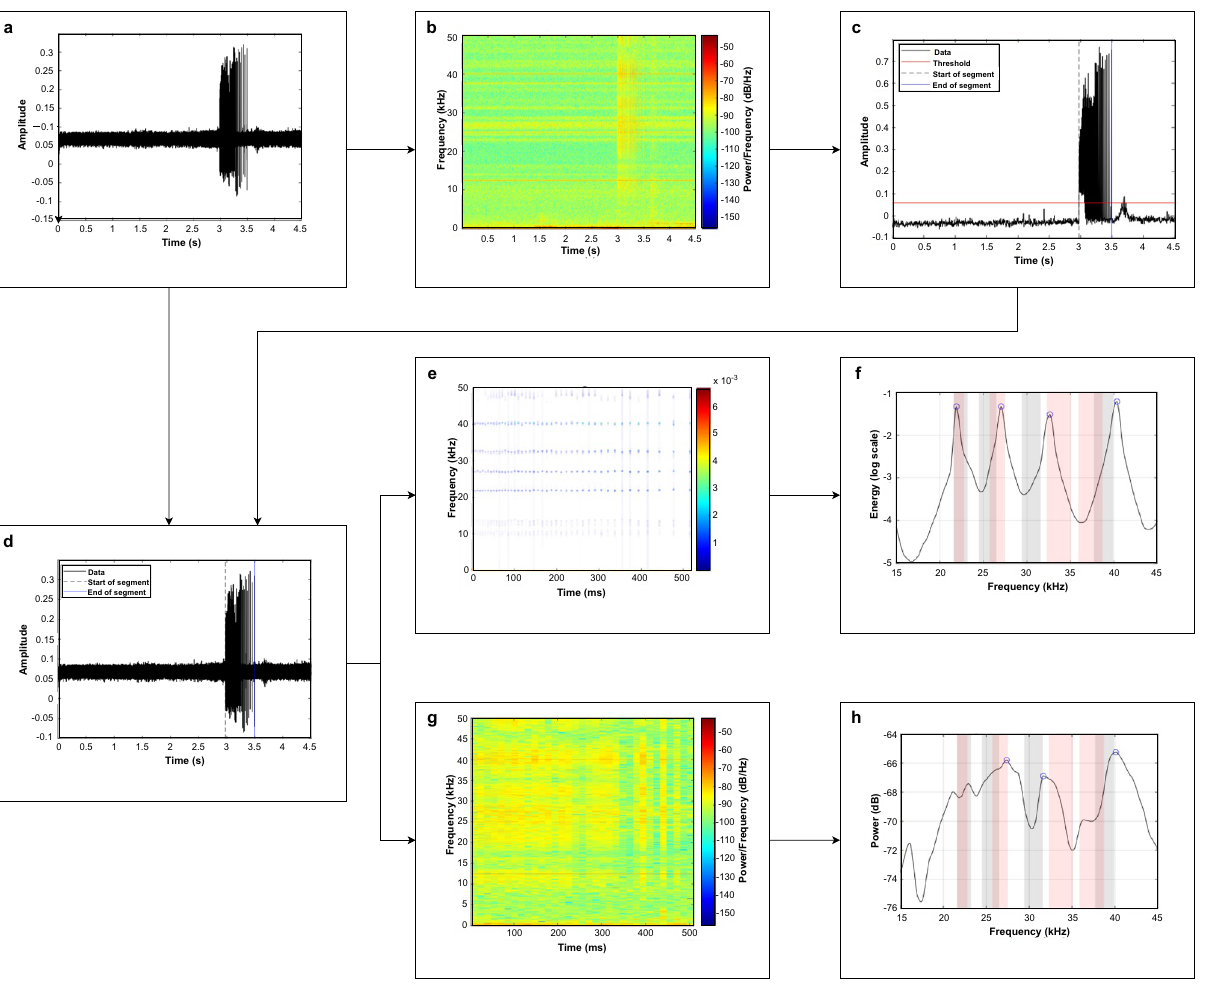
Figure 3. Flowchart demonstrating the usage of the VMD-gram . ( a ) The time-domain of the input signal, ( b ) the spectrogram of the audio file, ( c ) application of the threshold and defining time bounds, ( d ) isolating the significant signal component of the input signal using the time bounds from ( c ), ( e ) the VMD-gram of the segment, ( f ) the comparison of the segment to Soldevilla et al. 2008, ( g ) the spectrogram of the segment, and ( h ) the comparison of the segment to Soldevilla et al. (2008). Bars in ( f ) and ( h ) indicate the peaks in pulsed signals as documented by Soldevilla et al. (2008) for Gg (gray) and Lo